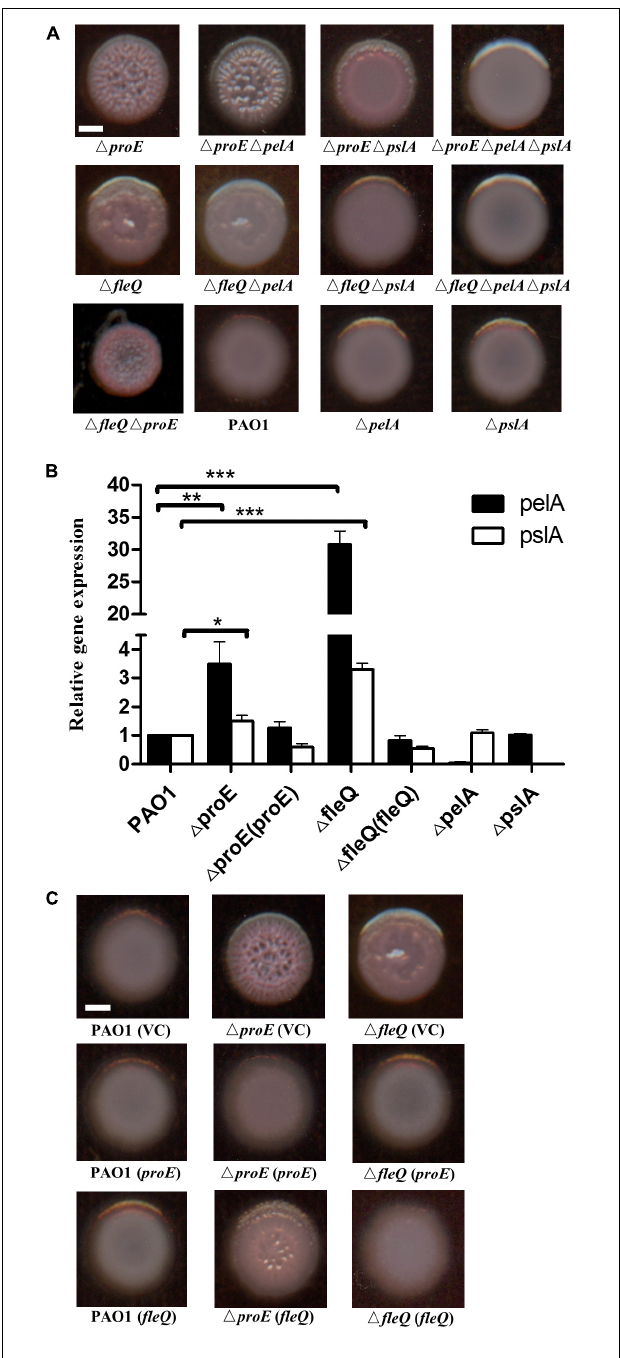
FIGURE 2 | ProE regulated EPS production was dependent on pel and psl . (A) The wrinkly colony is only abolished when both pelA and pslA are mutated in the (cid:49) fleQ background, while a pslA mutation is not sufficient to confer smooth colony morphology in the (cid:49) proE background. All strains were growth on Congo-Red plates. (B) The relative gene expression of pelA and pslA in PAO1, (cid:49) proE , (cid:49) fleQ , (cid:49) proE (proE), (cid:49) fleQ (fleQ), (cid:49) pelA , and (cid:49) pslA by qRT-PCR analysis. The data are means of three replicates and error bars indicate standard deviation. * P < 0.05; ** P < 0.01; *** P < 0.0001. (C) Complementation of proE can restore the wrinkly colony phenotype of (cid:49) fleQ , and complementation of fleQ can also substantially alleviate the wrinkly colony phenotype of (cid:49) proE . Scale bar = 2